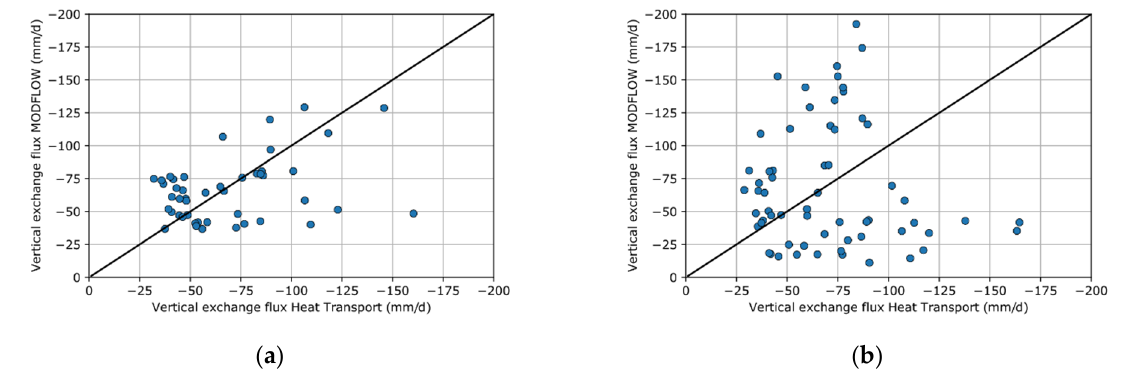
Figure 12. Scatterplots of simulated vertical flux estimates based on heat transport versus groundwater modelling for ( a ) the downstream section (R = 0.16) and ( b ) the upstream section (R = − 0.15). The black line is the one–one line.